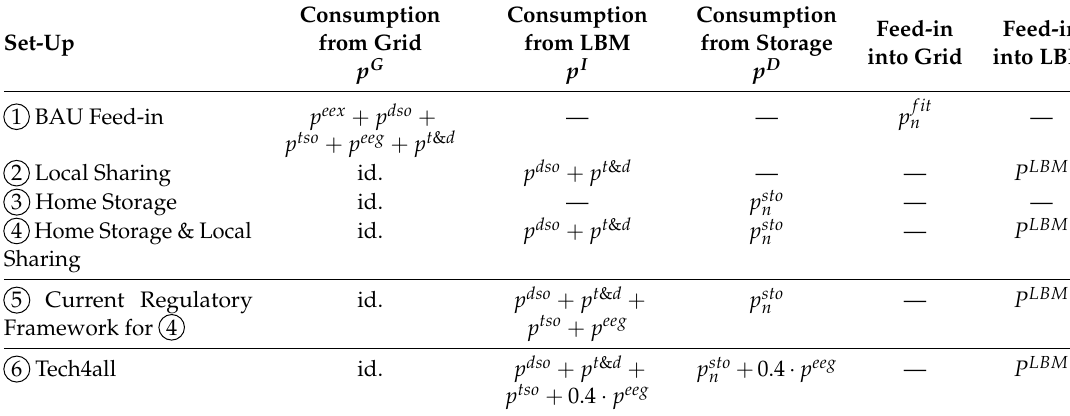
Table 3. Overview of simulated